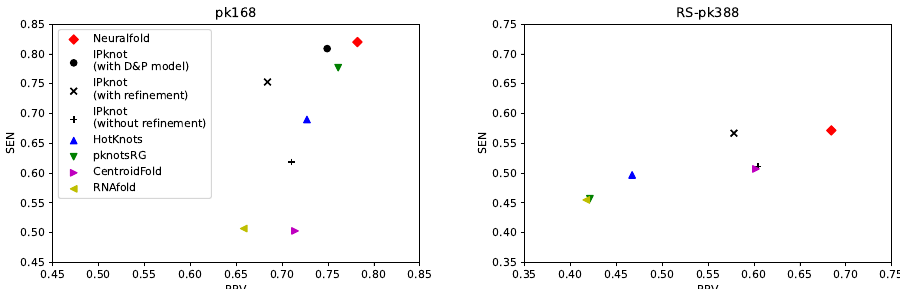
Figure 6. Positive predictive value–sensitivity (PPV–SEN) plots comparing our algorithm with competitive methods on the pk168 dataset ( Left ) and the RS-pk388 dataset ( Right ). For the pk168 dataset, we set γ ( 1 ) = 1, γ ( 2 ) = 3 for Neuralfold; γ ( 1 ) = 2, γ ( 2 ) = 4 for IPknot with the Dirks–Pierce (D&P) model; γ ( 1 ) = 2, γ ( 2 ) = 16 for IPknot with/without refinement; γ = 2 for CentroidFold. For the RS-pk388 dataset, we set γ ( 1 ) = 1, γ ( 2 ) = 3 for Neuralfold; γ ( 1 ) = 2, γ ( 2 ) = 2 for IPknot without refinement; γ ( 1 ) = 1, γ ( 2 ) = 1 for IPknot with refinement; γ = 2 for